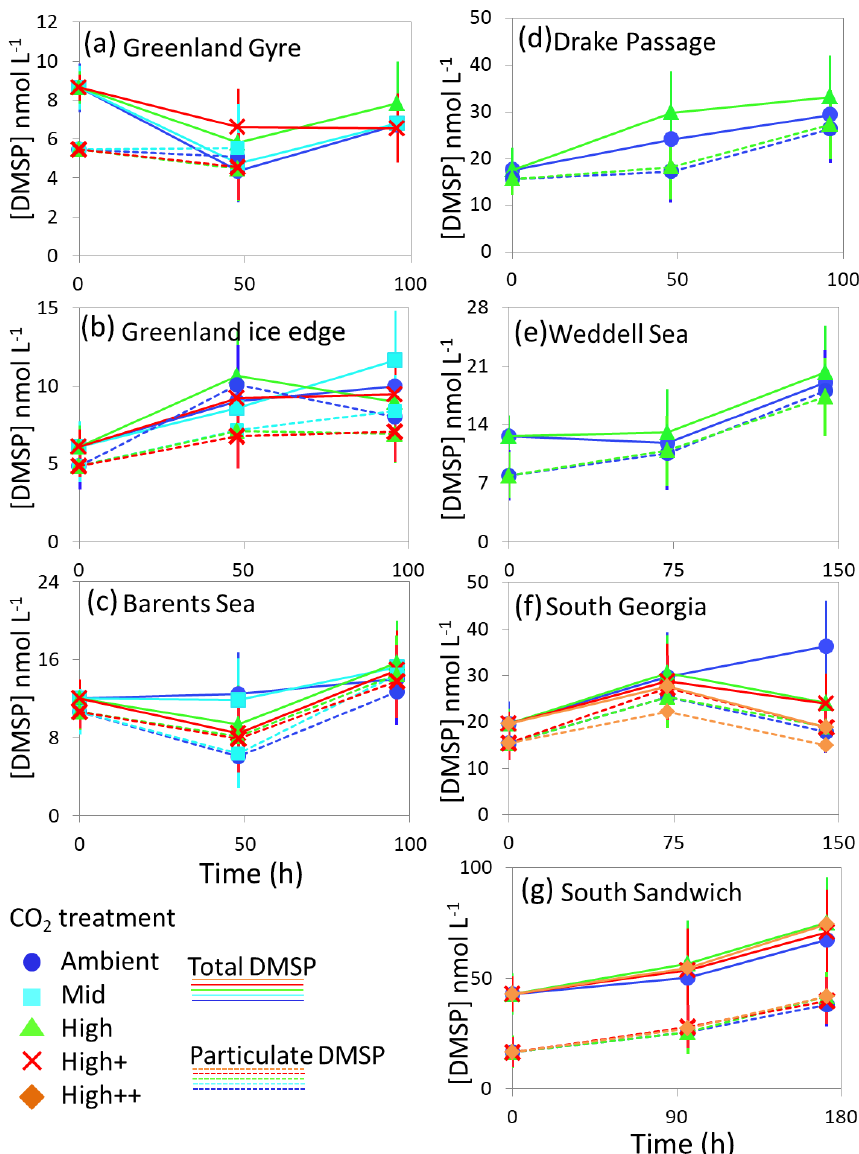
Figure 5. Total DMSP (solid lines) and particulate DMSP (dashed lines) concentrations (nmolL − 1 ) during experimental microcosms per- formed in Arctic waters (a–c) and in Southern Ocean waters (d–g) . Data shown are the mean of triplicate incubations, and error bars show the standard error on the mean. Locations of water collection for microcosms shown in Fig. 1c–f. Particulate DMSP concentrations were used in calculations of DMSP production rates (Fig.